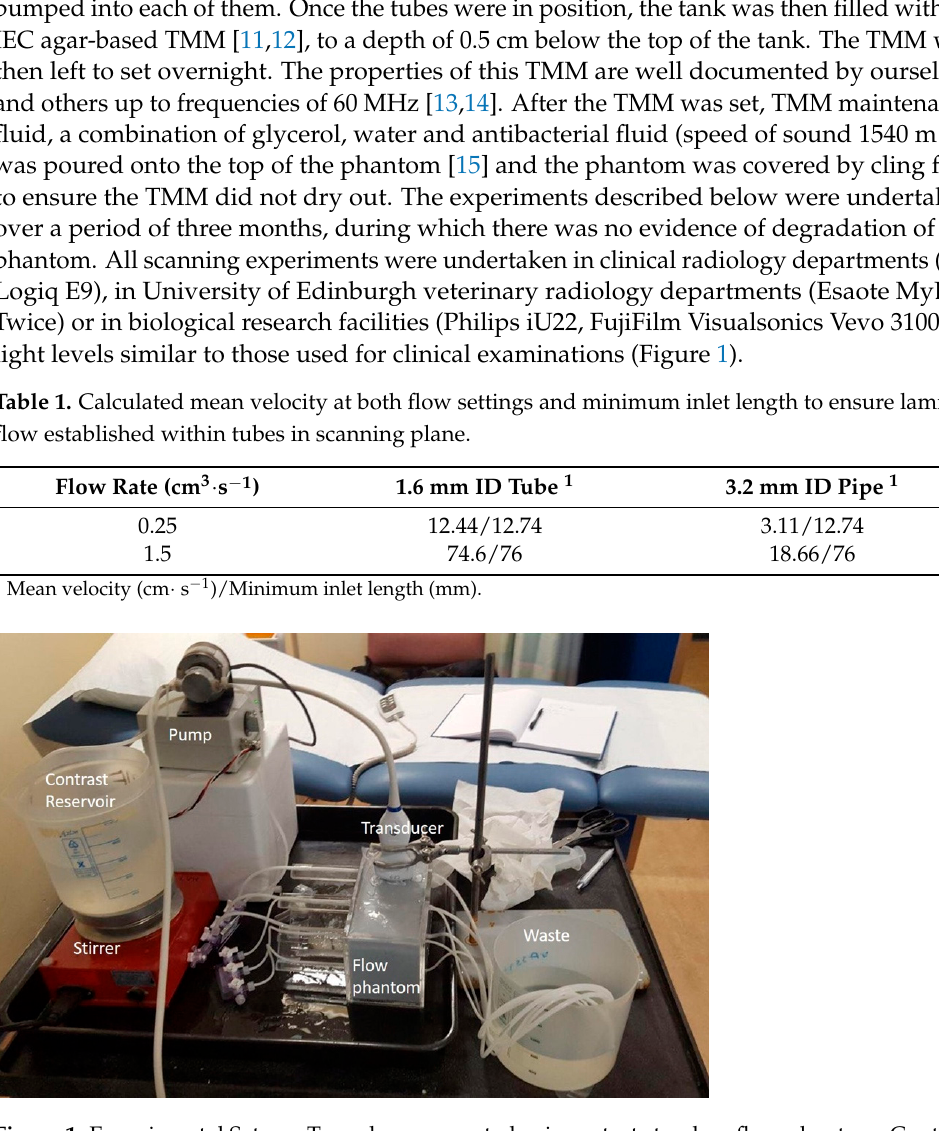
Figure 1. Experimental Set-up. Transducer mounted using retort stand on flow phantom. Contrast diluted in reservoir, then pumped into flow phantom.